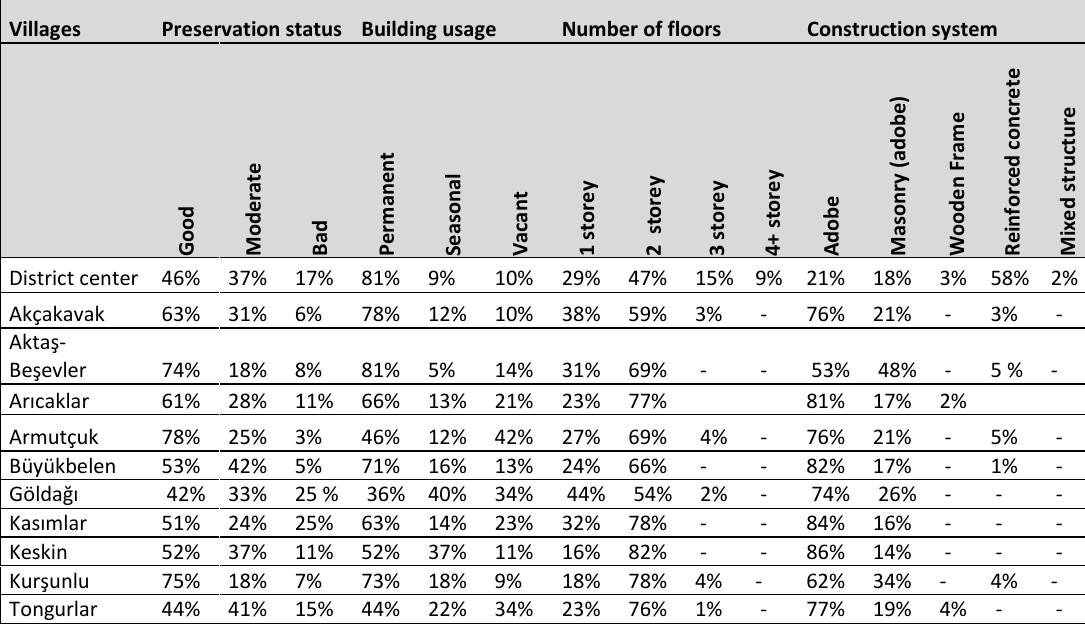
Table 1 Num erical data showing the settlement analysis of Gölpazarı villages Villages